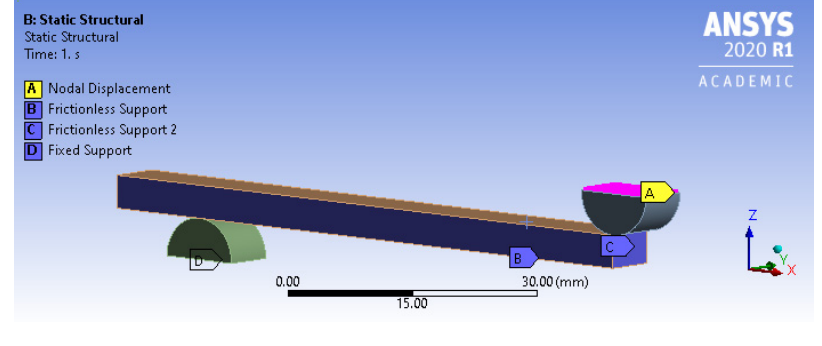
Figure 4. Contact boundary conditions that were assigned in the